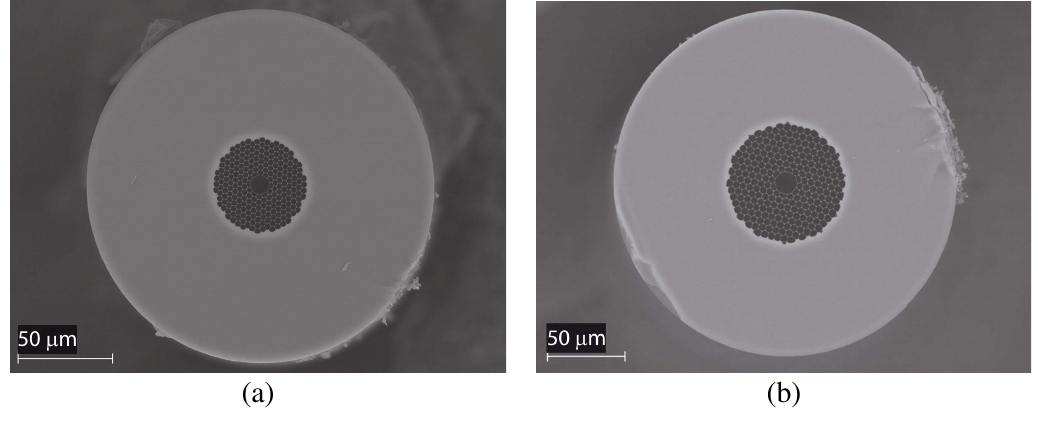
Figure 3. Normalized spectral transmission (solid black) and methane linestrengths (solid blue) of (a) a 5.6 m long HC1300 and methane lines at ν HC1600 and methane lines at 2 ν